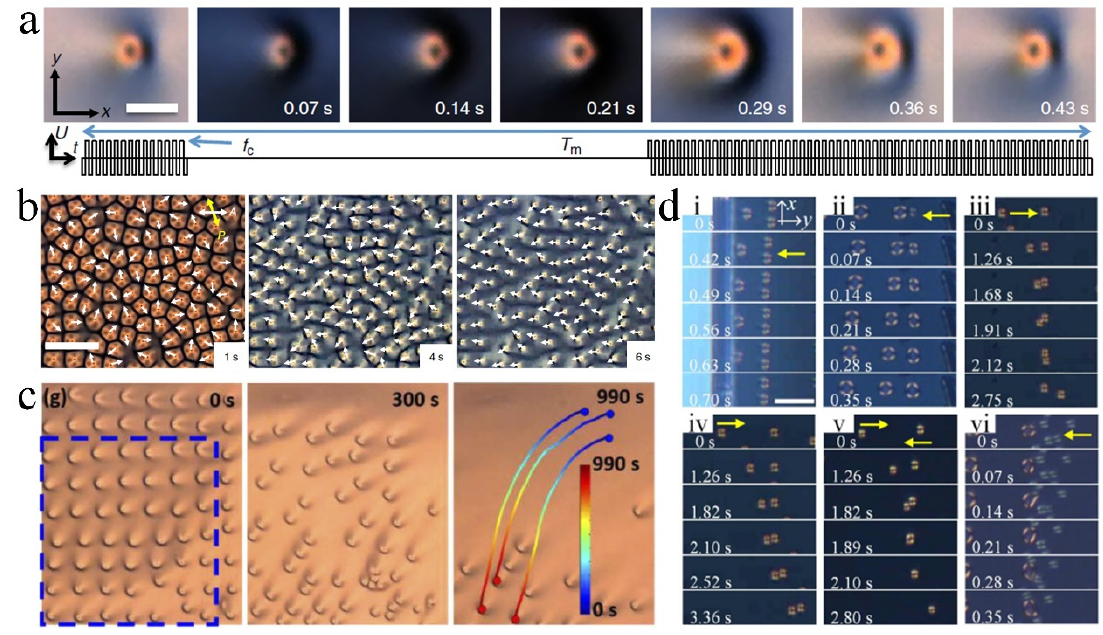
Figure 7. ( a ) Polarizing microscopy texture of a squirming skyrmion. Reprinted with permission from Ref. [90]. Copyright 2017 Nature. ( b ) Temporal evolution of skyrmion velocity order. Reprinted with permission from Ref. [92]. Copyright 2019 Nature. ( c ) Motion of skyrmions guided by light. Reprinted with permission from Ref. [93]. Copyright 2020 Optical Society of America. ( d ) Different dynamic behaviors of torons. Reprinted with permission from Ref. [95]. Copyright 2021 American Physical